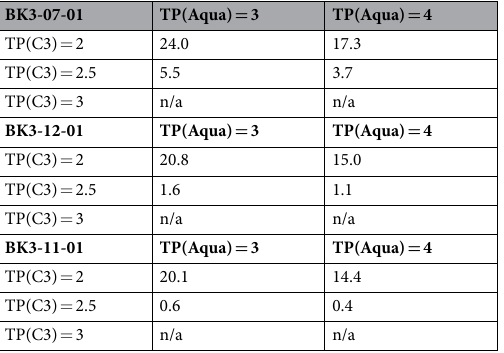
Table 3. Quantitative evaluation of freshwater resource consumption for the human individuals of Buran- Kaya III. Indicated percentages correspond to the contribution of either primary consumers (TP(Aqua) = 3) or secondary consumers (TP(Aqua) = 4) from aquatic ecosystem to the human diet in association to terrestrial plants (TP(C 3 ) = 2), or terrestrial primary consumers (TP(C 3 ) = 3), or a 50:50 mix of terrestrial plant and herbivores (TP(C 3 ) = 2.5). These calculations are indicative since the values of the end-members are based on the theoretical TP lines. n/a (non applicable) stands for unsolvable